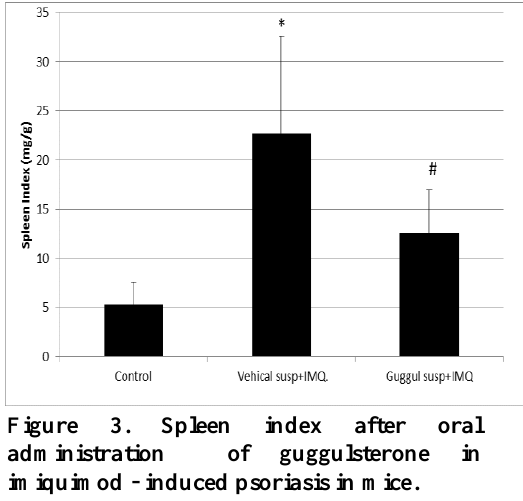
Figure 3. Spleen index after oral administration of guggulsterone in imiquimod - induced psoriasis in mice. - Each value represents mean ± standard deviation (SD).